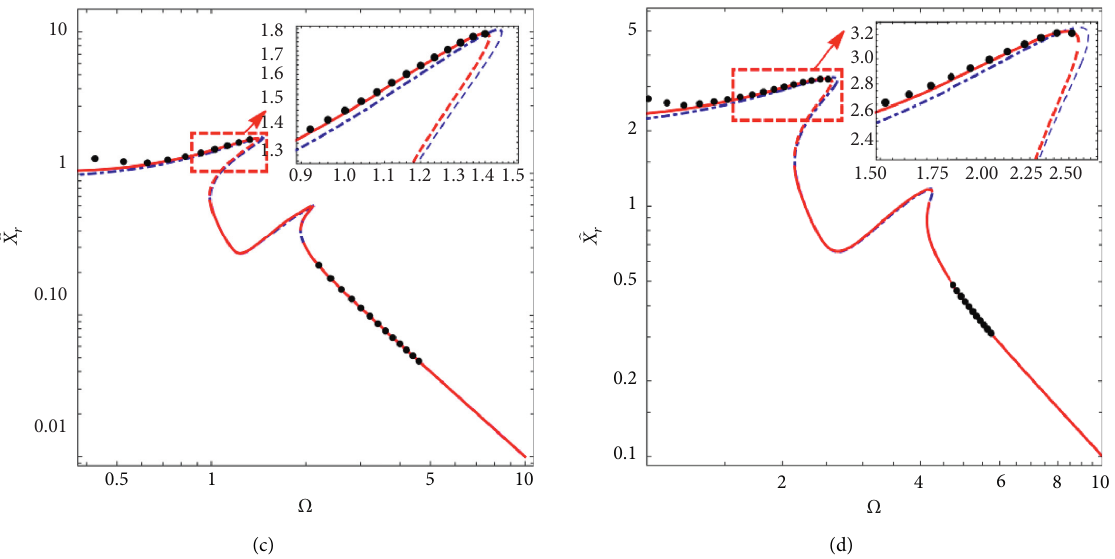
Figure 4: Amplitude-frequency curves of the relative displacement between m k k � 1, k k � k k � 7/6, 􏽢 l � 0 . 7, and (a) 􏽢 F v 2 / v 1 h 1 / v 1 h 2 / v 1